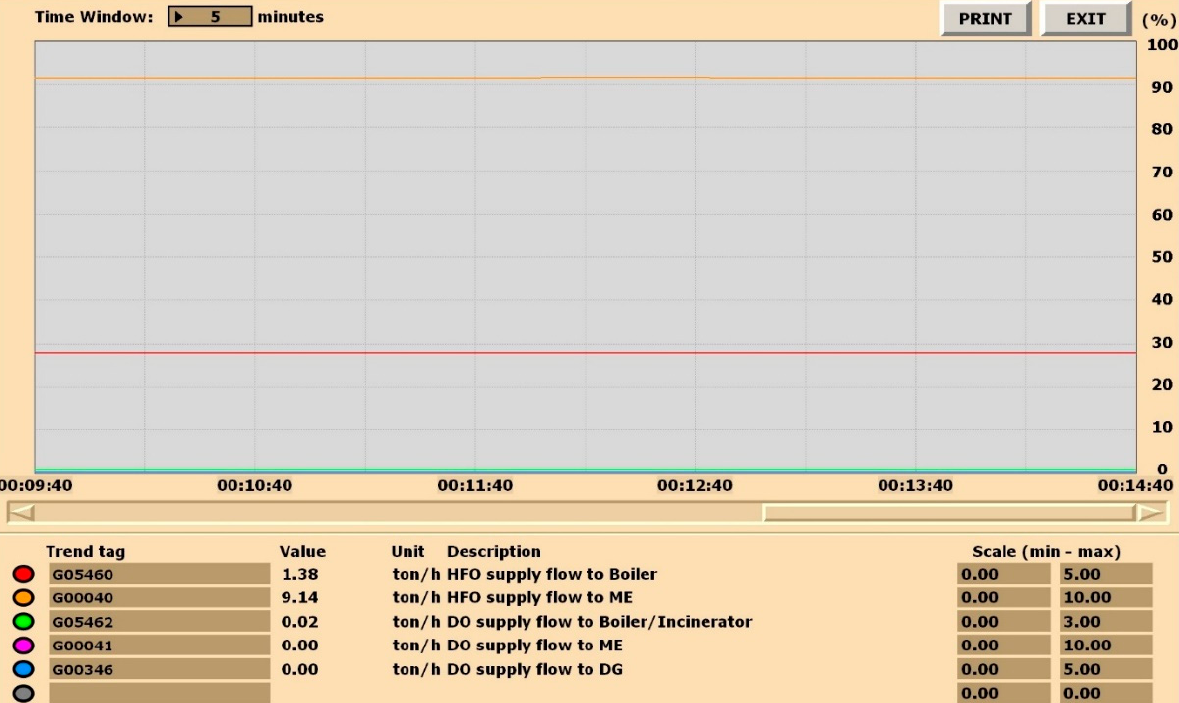
Figure 6. Fuel flows for mode 2.2 (container ship). The first column indicates the modes of operation used: modes 1.1 through 1.4 represent the 5MC90 motor, while modes 2.1 and 2.2 represent the RT-Flex 82C L11 motor. The second, third, and fourth columns indicate the fuel flows to the main engine, boiler, and diesel generators, respectively, measured at the outlet pipes of the service tanks. Travel time was calculated using Equation (2), and vessel speed was taken from the bridge control panel. B total is the total fuel consumption, and carbon dioxide emissions were calculated assuming that all the carbon in the fuel had been converted to carbon dioxide. Carbon dioxide emission was calculated from the data in the seventh column of the Table 3 ( B total ), where the mass fraction of carbon was about 83% 4 (4 There may be fuels with a different mass fraction of carbon, but it is a common value for heavy oils used mainly in large diesel engines.). This number was multiplied by the coefficient 3.67, which